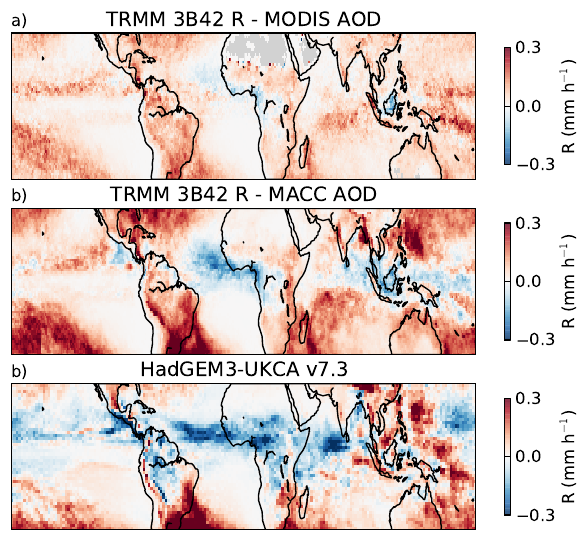
Figure 1. The difference in the TRMM merged precipitation rate between the highest and lowest AOD quartiles when using (a) MODIS and (b) MACC AOD between 2003 and 2007. (c) The same as (a) but using 5 years of HadGEM3-UKCA precipitation and AOD. Red (blue) indicates an increase (decrease) in precipita- tion for the high AOD